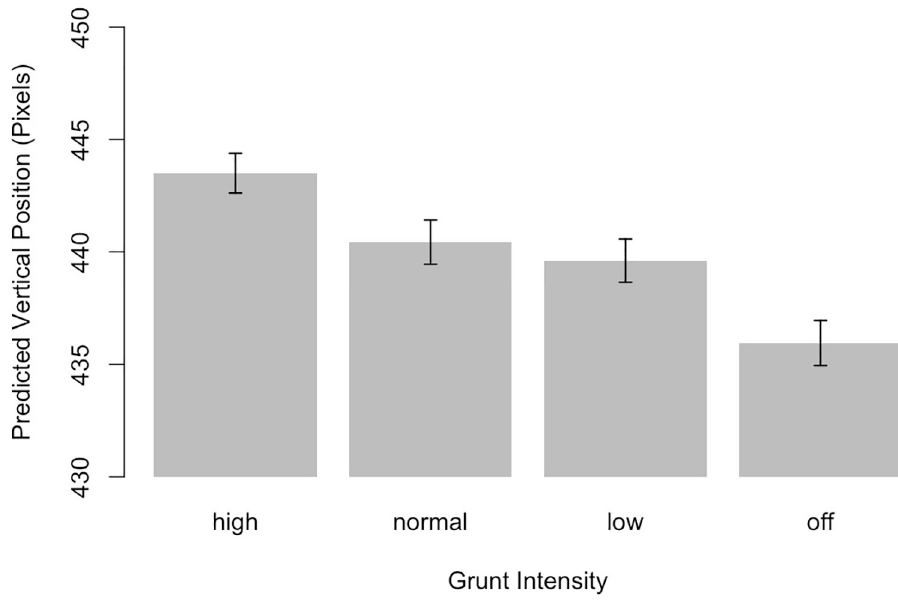
Fig 2. The influence of grunt intensity on judgments of the ball’s landing position in the longitudinal (i.e., vertical) axis. Error bars indicate 95% confidence intervals.